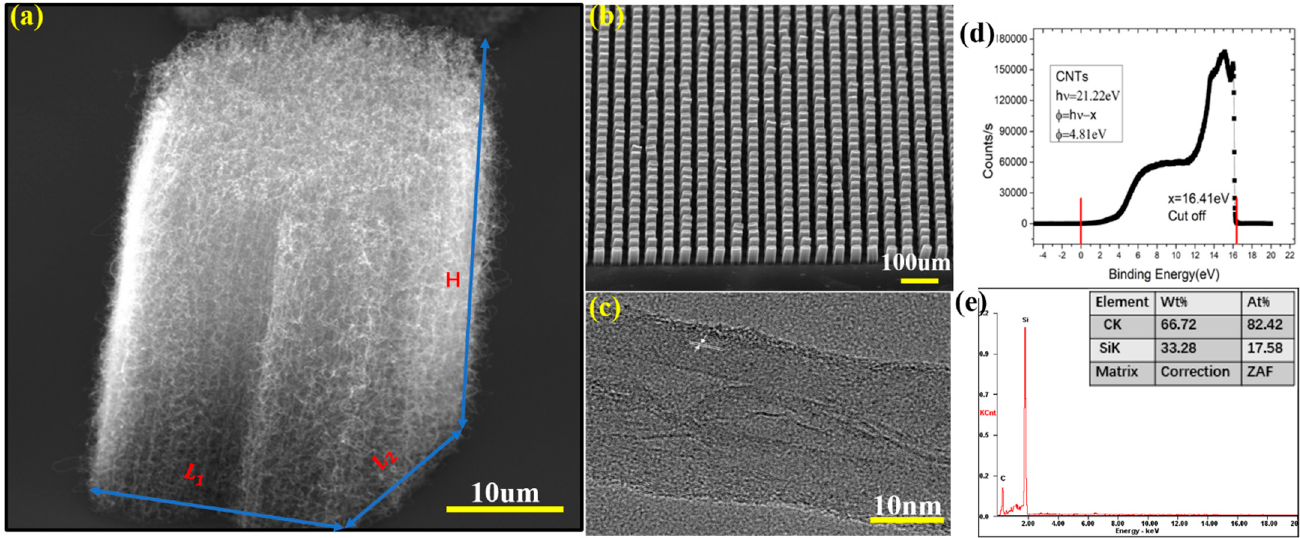
Figure 1. SEM images of ( a ) a cluster of nanotubes, and ( b ) a top view of the aligned CNT-array sample, ( c ) (HR)TEM images of the single CNT, ( d ) A work function of 4.81 eV is determined from the secondary emission onset in ultraviolet photoelectron spectroscopy, ( e ) EDS test of the aligned CNT-arrays sample.